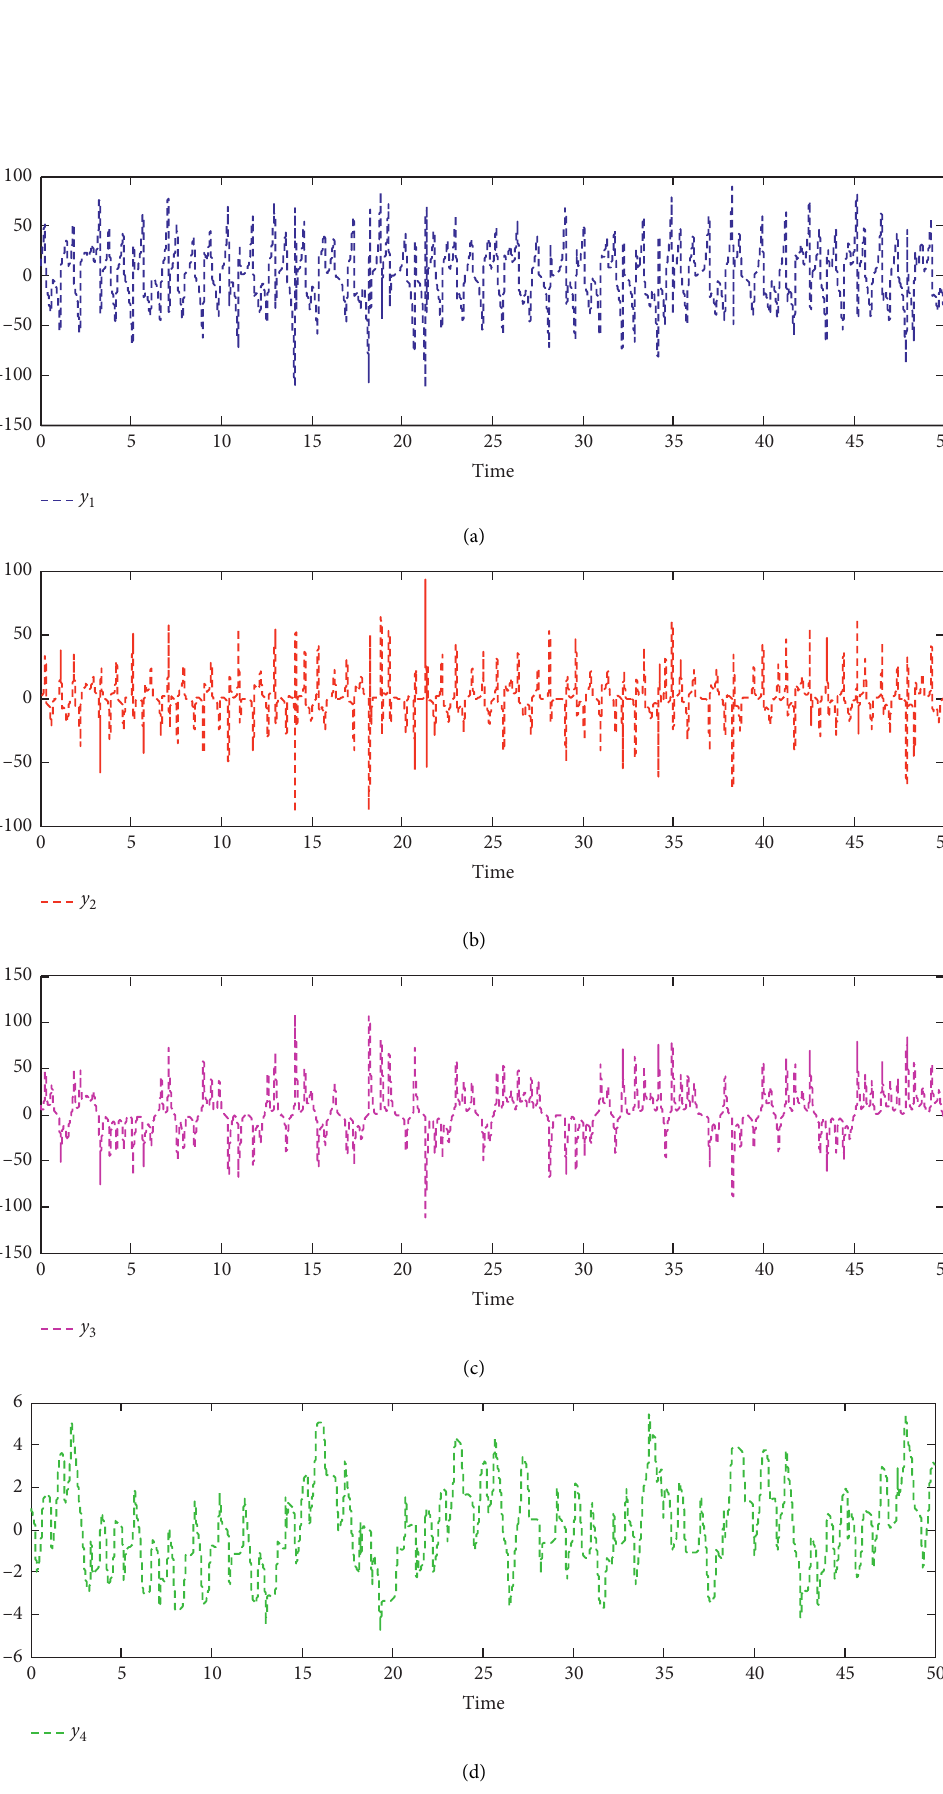
Figure 3: Time history of state variables of the four-wing nonlinear hyperchaotic complex